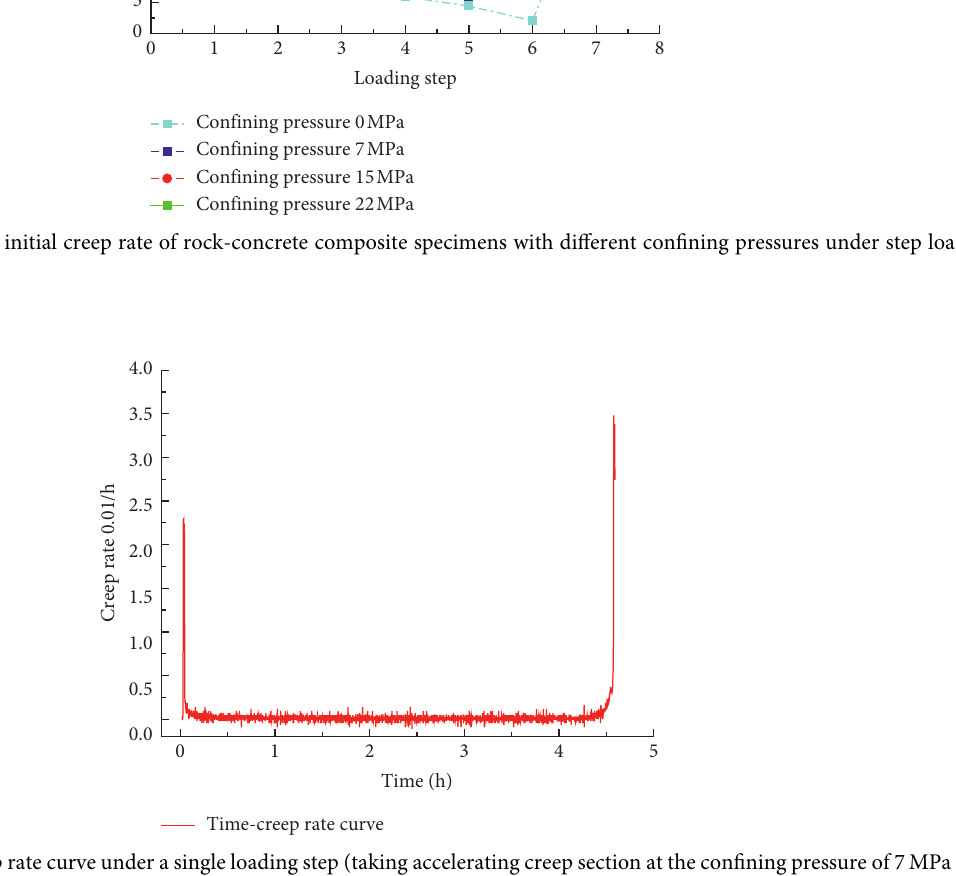
Figure 6: Creep time-creep rate curve under a single loading step (taking accelerating creep section at the confining pressure of 7MPa as an